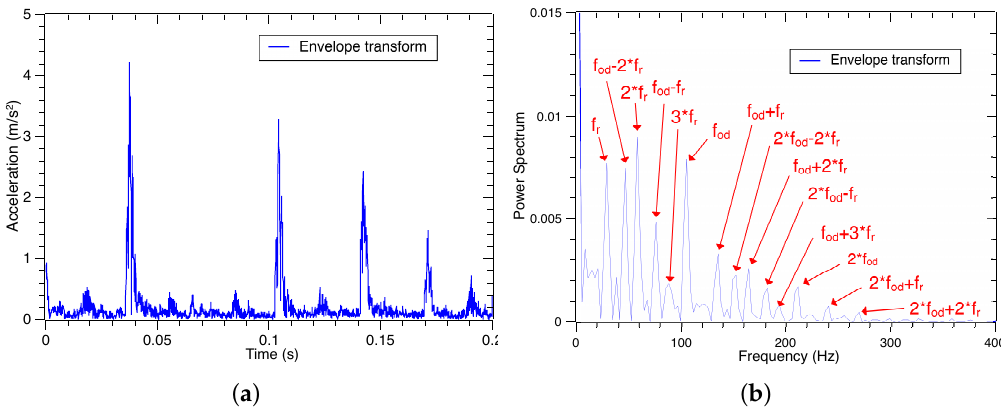
Figure 6. The envelope waveform and spectrum of the raw vibration signal under the outer race